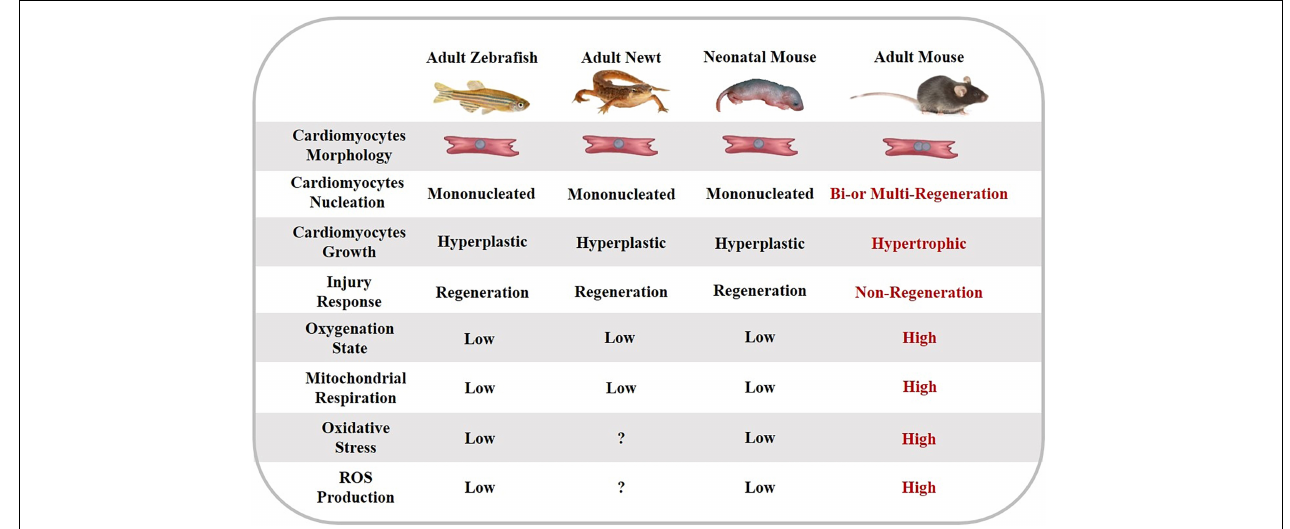
FIGURE 1 | The characteristics of cardiomyocyte regeneration in different species and life stages.